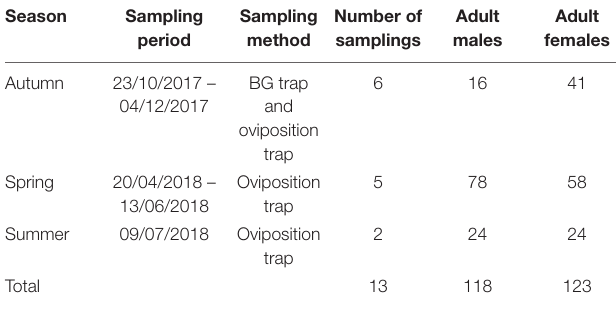
TABLE 1 | Season and sampling period, number of samplings, sampling method and number of males and females of Ae. albopictus that were collected for wing geometric